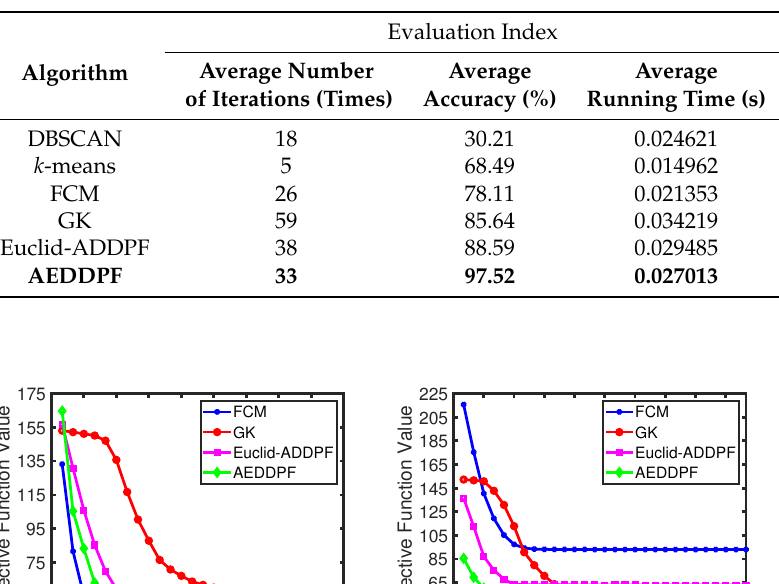
Table 3. Comparison experiment of AEDDPF algorithm with other algorithms in radar dataset.